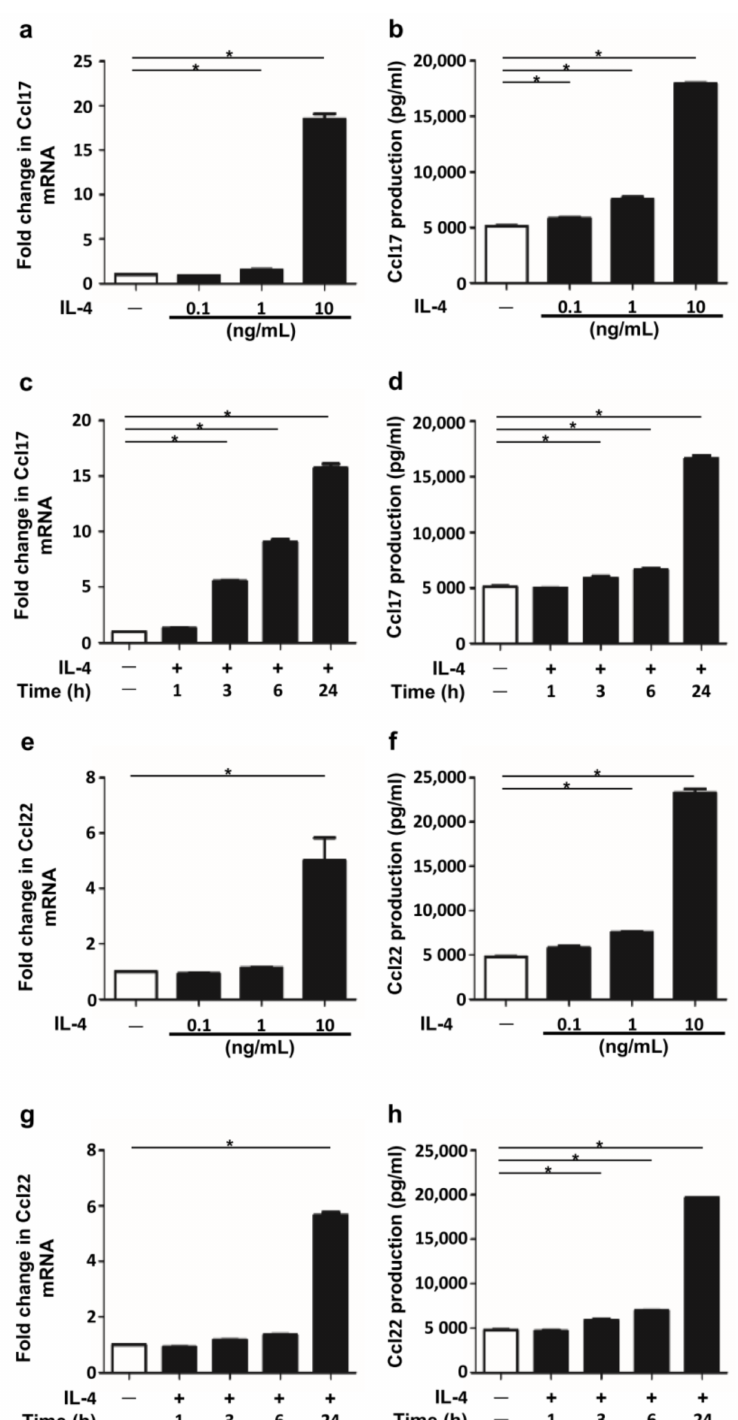
Figure 1. IL-4 stimulation induced Ccl17 and Ccl22 production in bone marrow-derived dendritic cells (BMDCs). ( a – d ) Data are expressed as mean ± standard error of the mean (S.E.M.); n = 3 for each group; * p < 0.05. Expression of Ccl17 ( a ) and Ccl22 ( e ) in BMDCs stimulated with IL-4 (0.1, 1 and 10 ng/mL) for 24 h and production of Ccl17 ( b ) and Ccl22 ( f ) in the culture supernatant were measured. Expression of Ccl17 ( c ) and Ccl22 ( g ) in BMDCs stimulated with IL-4 (10 ng/mL) for 1, 3, 6 and 24 h and production of Ccl17 ( d ) and Ccl22 ( h ) in the culture supernatant were